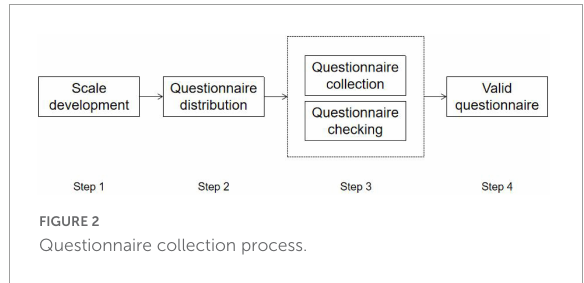
FIGURE2 Questionnaire collection process.